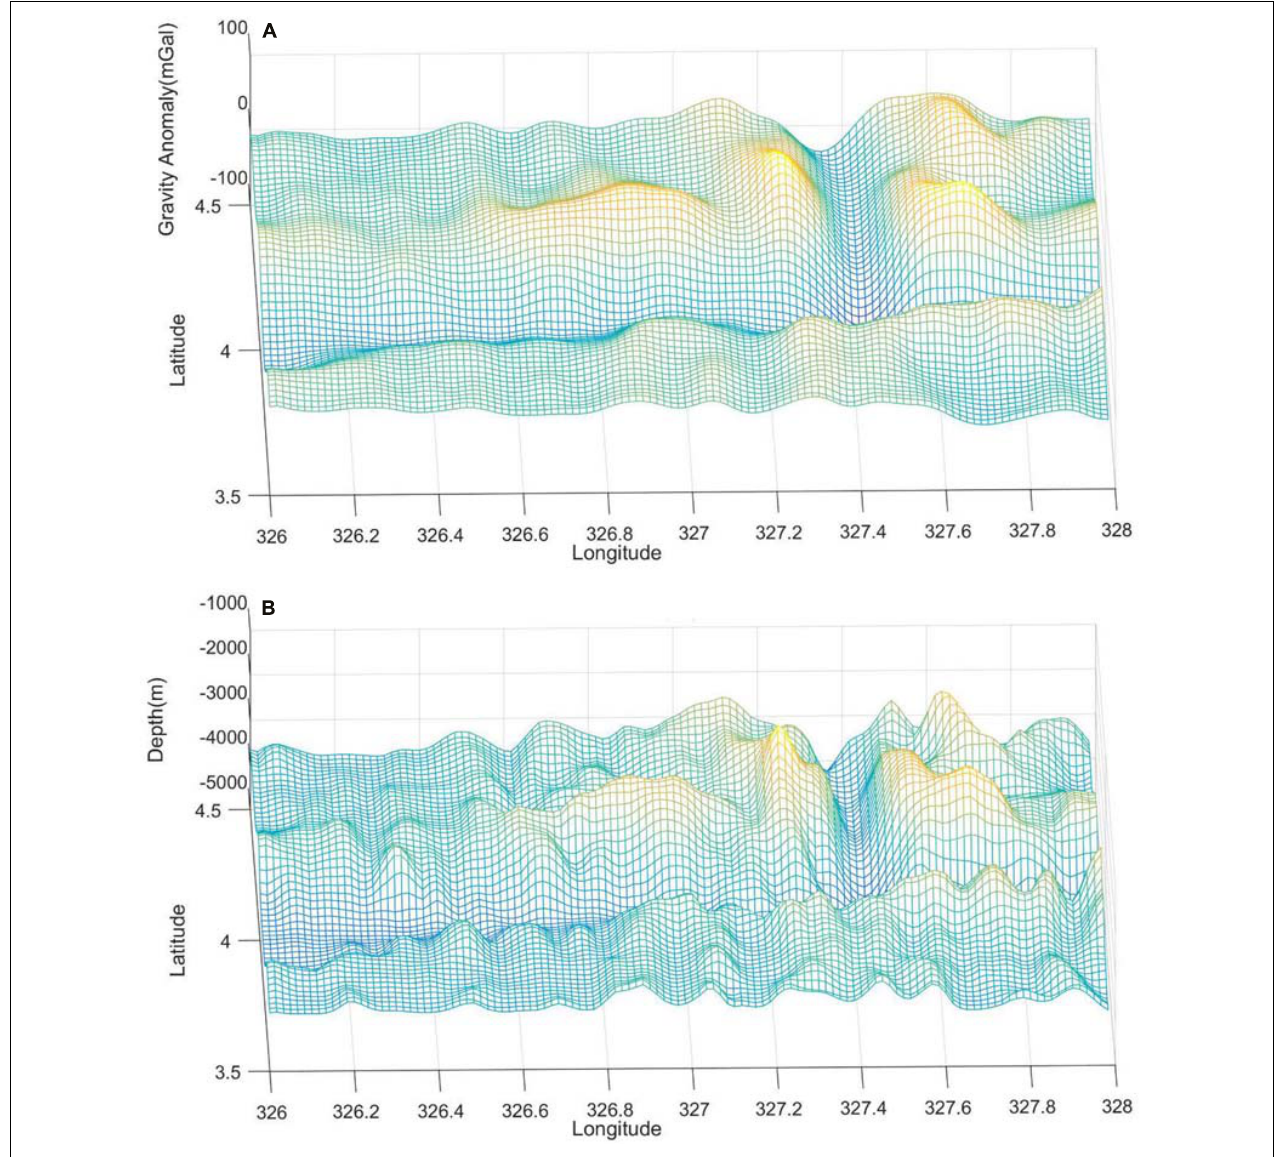
FIGURE 2 | Three-dimensional distribution of gravity anomaly (A) and shipborne depths (B)